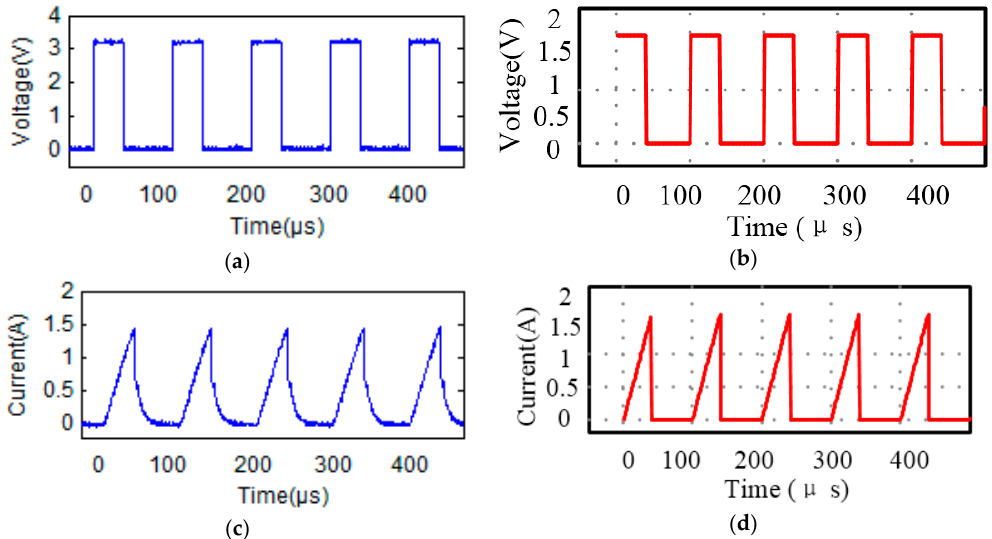
Figure 13. The comparison of i L 1 . ( a ) pulse-width modulation (PWM) in the experiment. ( b ) PWM in the simulation. ( c ) i L 1 in the experiment. ( d ) i L 1 in the simulation.